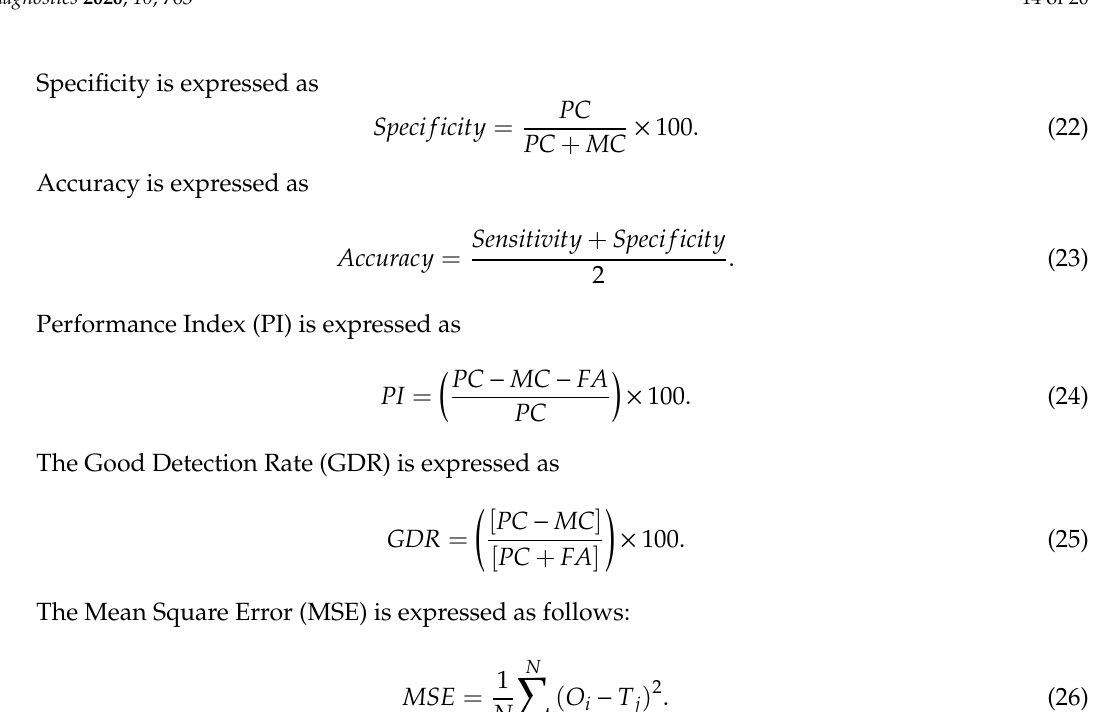
Table 7. Average parameters at various optimization techniques with di ff erent features for normal cases. Features Optimization Methods Mean Variance Skewness Kurtosis Geometric Mean Harmonic Mean Fuzzy-Inspired and Modeled